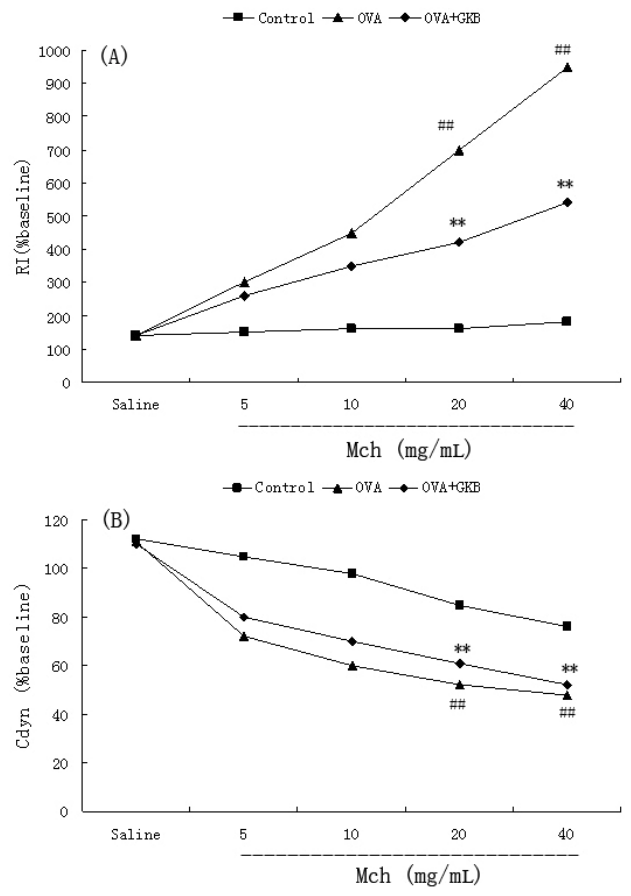
Figure 4. Effects of ginkgolide-B on OVA-induced airway hyper-responsiveness in mice. Airway hyper-responsiveness was assessed by percentage change from the baseline level of (A) lung resistance (RI, n = 10 mice per treatment group) and (B) dynamic compliance (Cdyn, n =10 mice per treatment group). GKB = ginkgolide-B, Mch = Methacholine